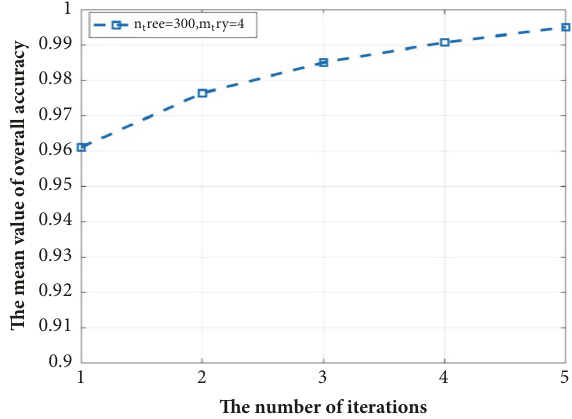
Figure 30: Classification accuracy trend of different initial and iterative condition of Hyperion data for method